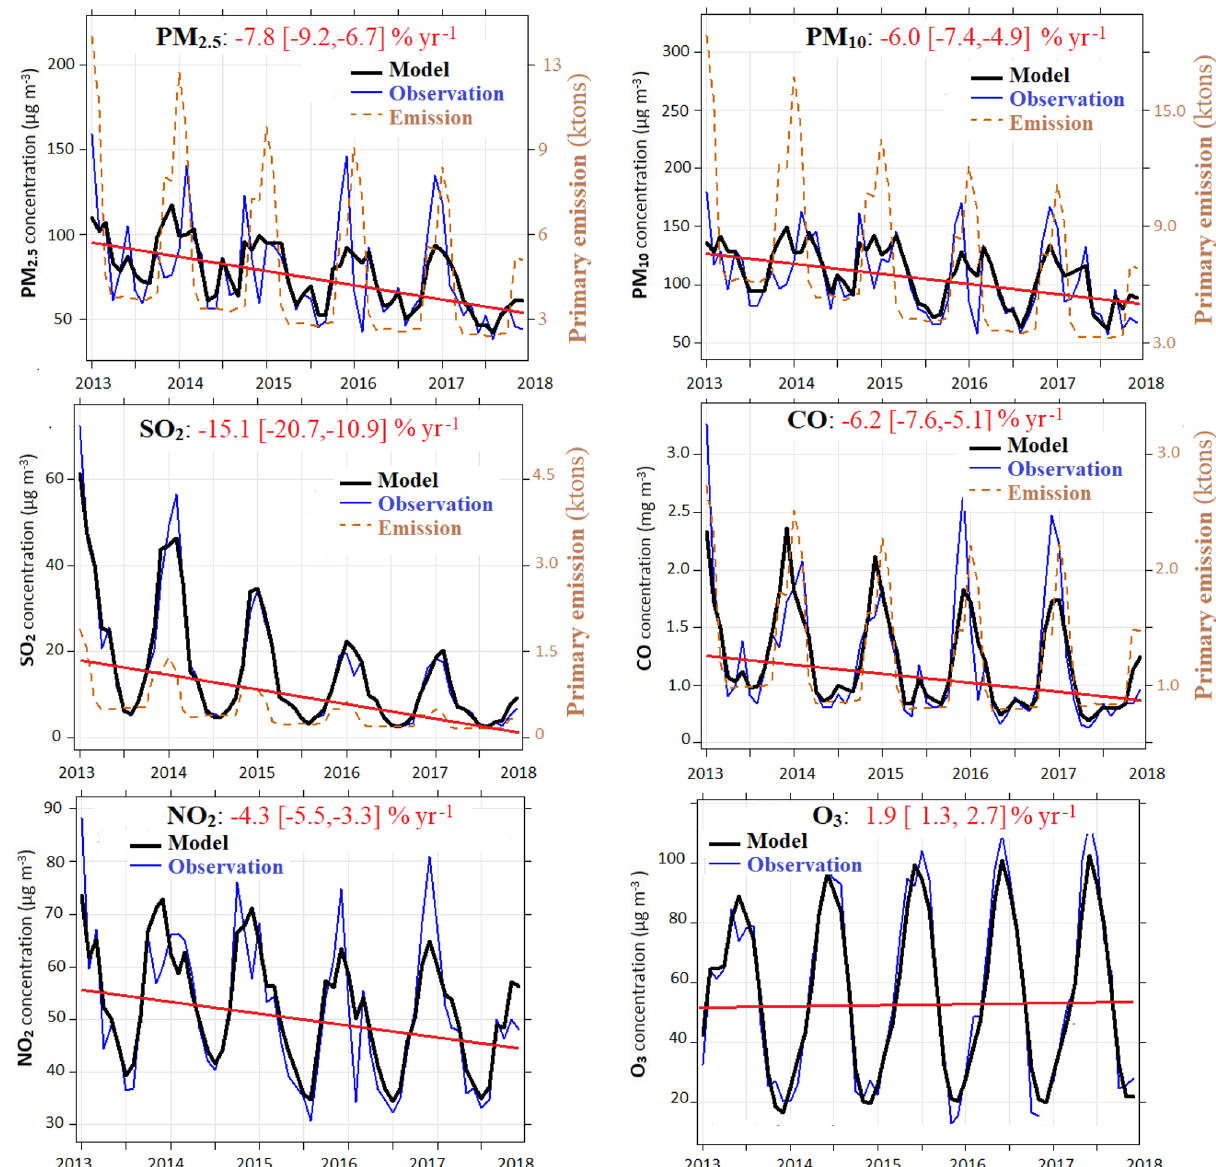
Figure 2. Air quality and primary emissions trends. Trends of monthly average air quality parameters before and after normalization of weather conditions (first vertical axis), and the primary emissions from the MEIC inventory (secondary vertical axis). “Model” in the figure means the modelled concentration of a pollutant after weather normalization. The red line shows the Theil–Sen trend after weather nor- malization. The black and blue dotted lines represent weather-normalized and ambient (observed) concentration of air pollutants. The red dotted line represents total primary emissions. The levels of air pollutants after removing the weather’s effects decreased significantly with median slopes of 7.2, 5.0, 3.5, 2.4, and 120µgm − 3 year − 1 for PM 2 . 5 , PM 10 , SO 2 , NO 2 , and CO, respectively, while the level of O 3 slightly increased by 1.5µgm − 3 year − 1